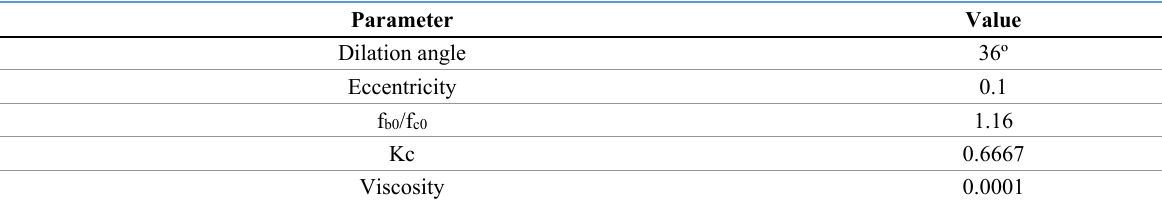
Table 3. Parameters of Concrete Damaged